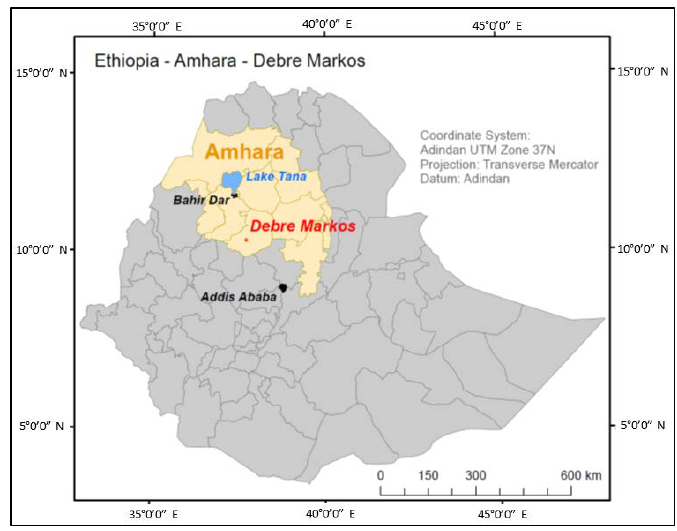
Figure 1. The study area. Debre Markos is situated 2400 m above sea level. The town has a 1380 mm average annual rainfall and a minimum and maximum temperature of 15 ◦ C and 22 ◦ C. Debre Markos town is one of the high land areas of the country. The town, which includes the rural kebeles in its environs, is home to about 262, 497 inhabitants. According to the municipality’s report, 97% of them are from the Amhara nation and the rest are from Agaw, Oromo, Tigre and other nations/nationalities. Most of the town’s residents are Orthodox Christians. The rests are Muslims and